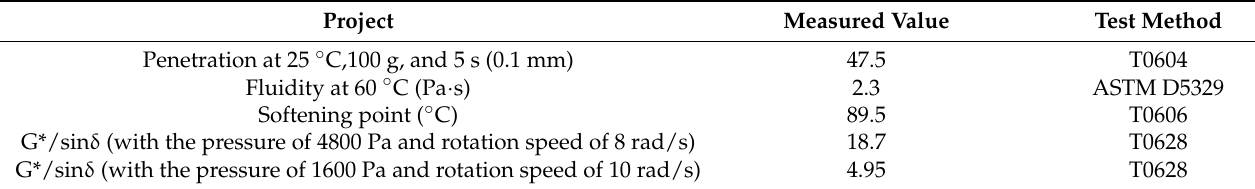
Table 3. Technical indices of rubber